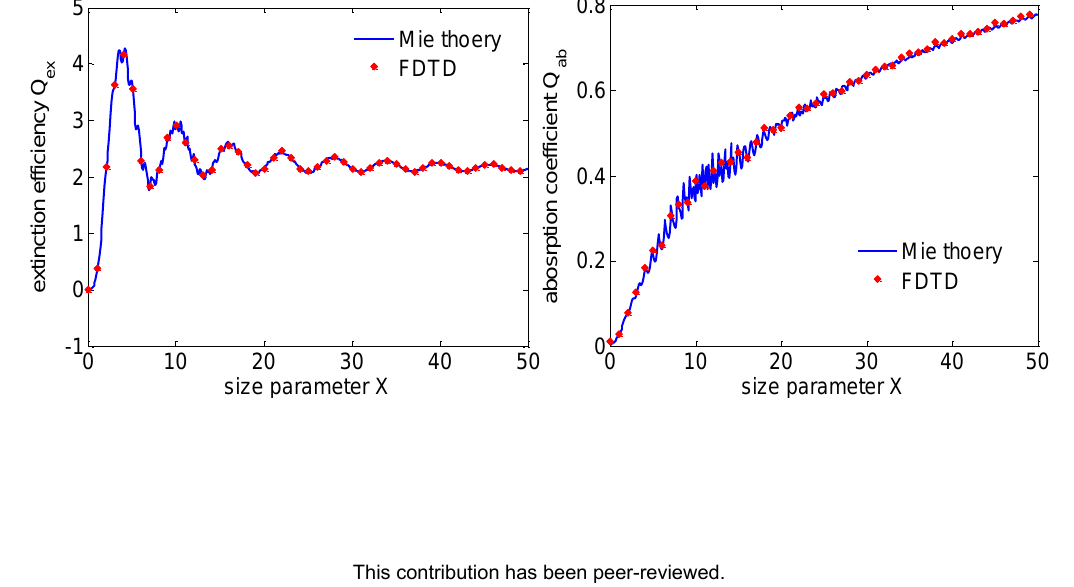
The results show that the integral scattering parameters obtained by the two models are in good agreement in the variation range of size parameter X, where the maximum simulation errors of extinction efficiency Q ex , absorption efficiency Q ab and single scattering albedo SSA are 3.63%, 4.67% and 0.5% respectively. In terms of error magnitude, the simulation accuracy of particle integral scattering parameters is higher than that of Müeller